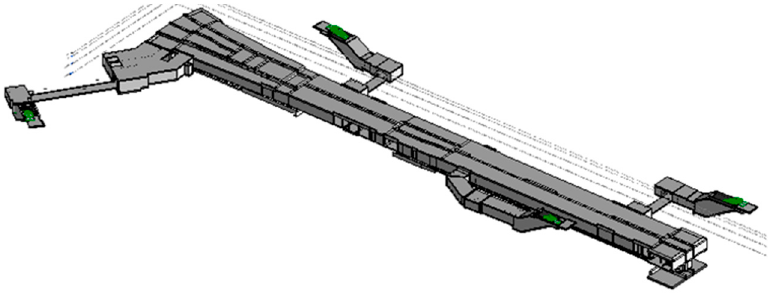
Figure 4. BIM model of the subway station.